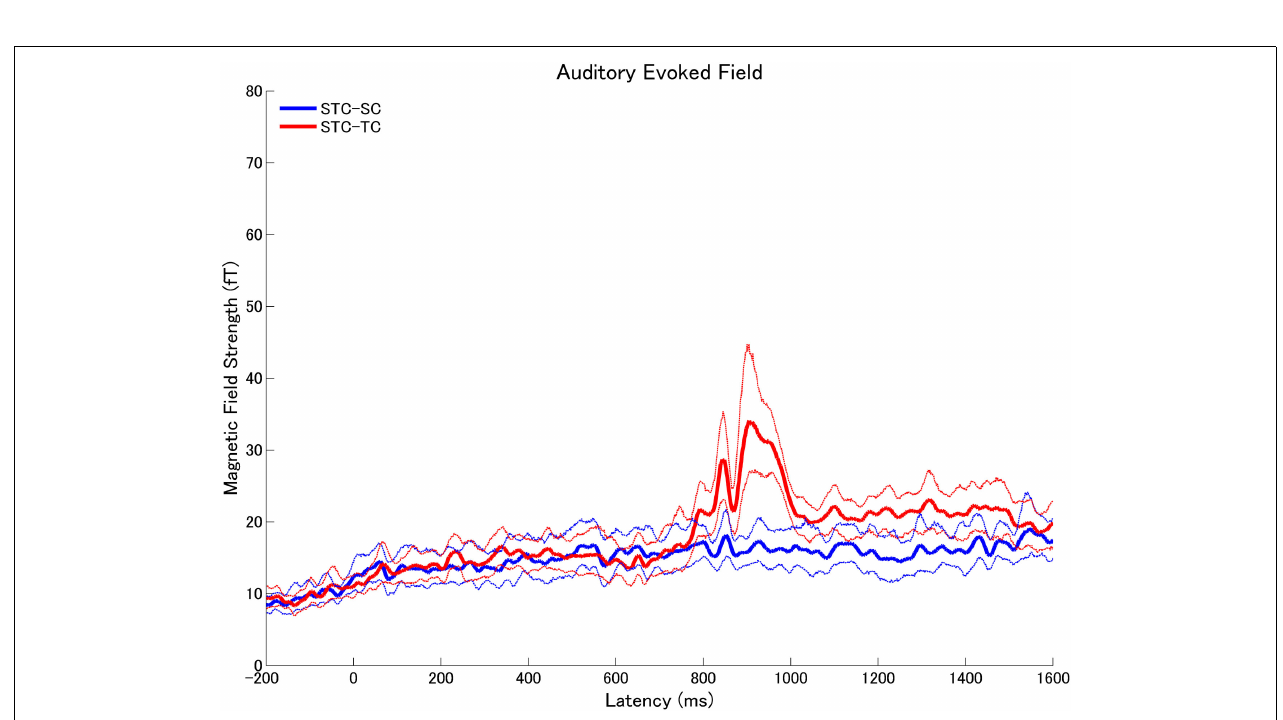
FIGURE 9 |The means (solid lines) and the 95% confidence interval limits (dashed lines) of the root-mean-square (RMS) values of the subtracted auditory evoked fields (STC – SC: blue, STC –TC: red) across all subjects in experiment 1.